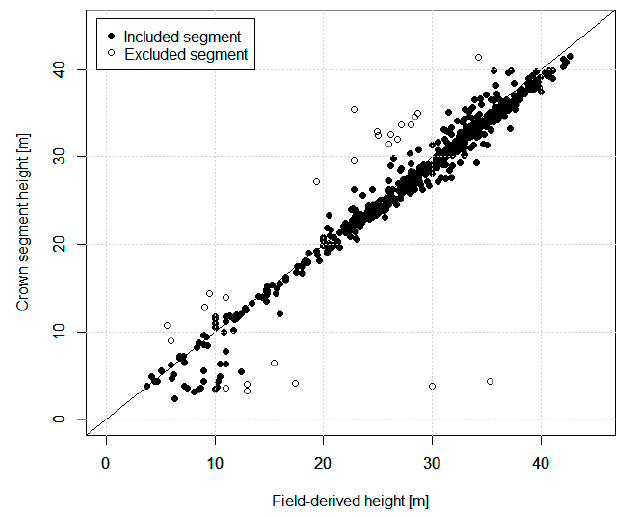
Figure 2. The field-derived tree height of the matched field trees and the respective maximum airborne laser scanning (ALS) height of crown segments.